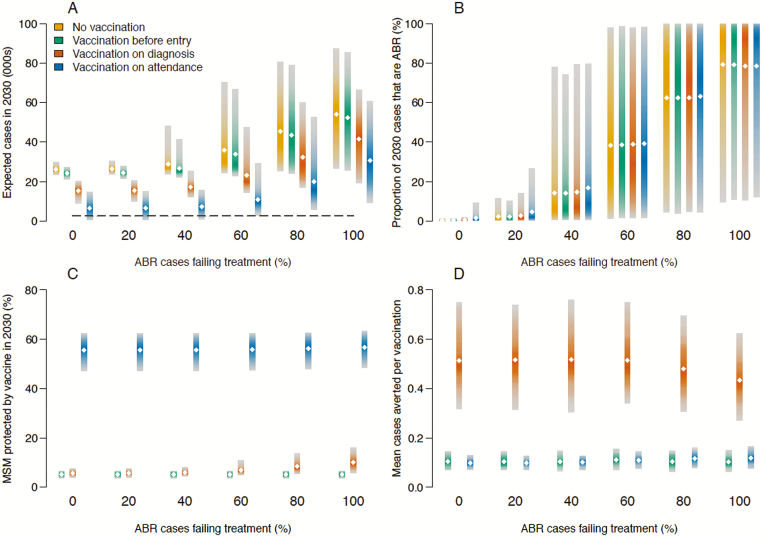
Potential impact and efficiency of an outer-membrane vesicle meningococcal B (MeNZB)–like vaccine. Vaccination was implemented before entry into the sexually active population, on diagnosis, or on clinic attendance. Shaded bars depict the 95% predictive interval; diamonds indicate the mean. A, Expected gonorrhea cases in 2030, with the dashed line depicting the World Health Organization target. B, Proportion of gonorrhea cases expected to be resistant in 2030. C, Proportion of men who have sex with men protected by the vaccine in 2030. D, Mean cases averted per course of vaccination. Abbreviations: ABR, antibiotic-resistant; MSM men who have sex with men.